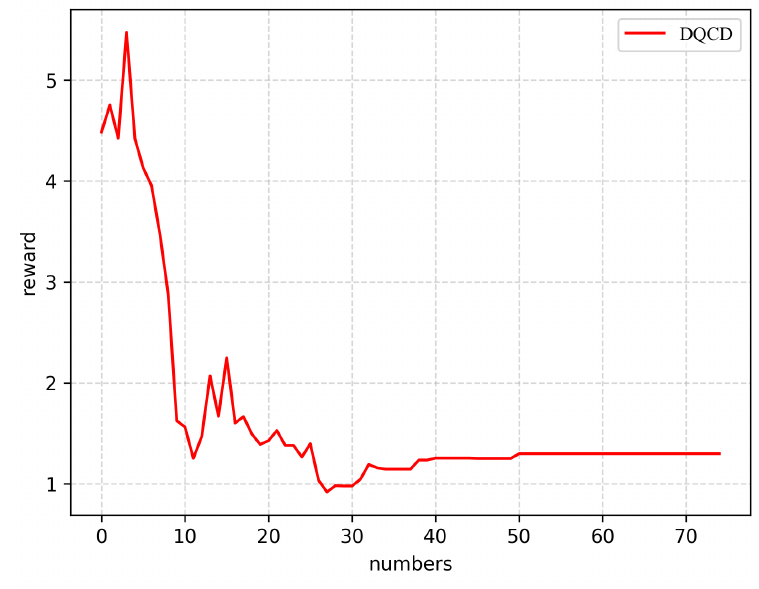
Figure 2. DQCD training convergence